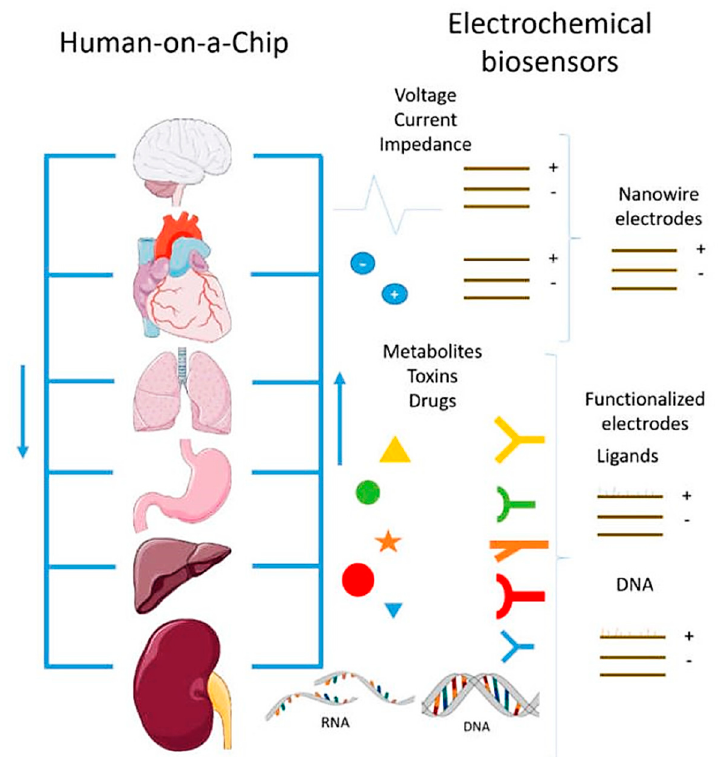
Figure 4. Representation of the biosensors for a human-on-a-chip platform. Reprinted from ref. [70].